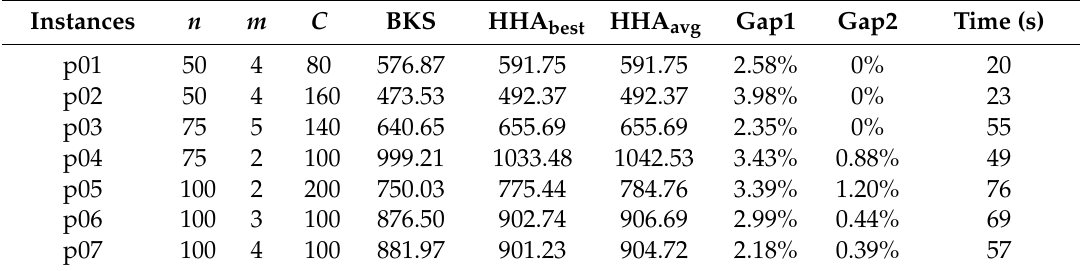
Table 3. The results of HHA in solving MDVRP benchmark